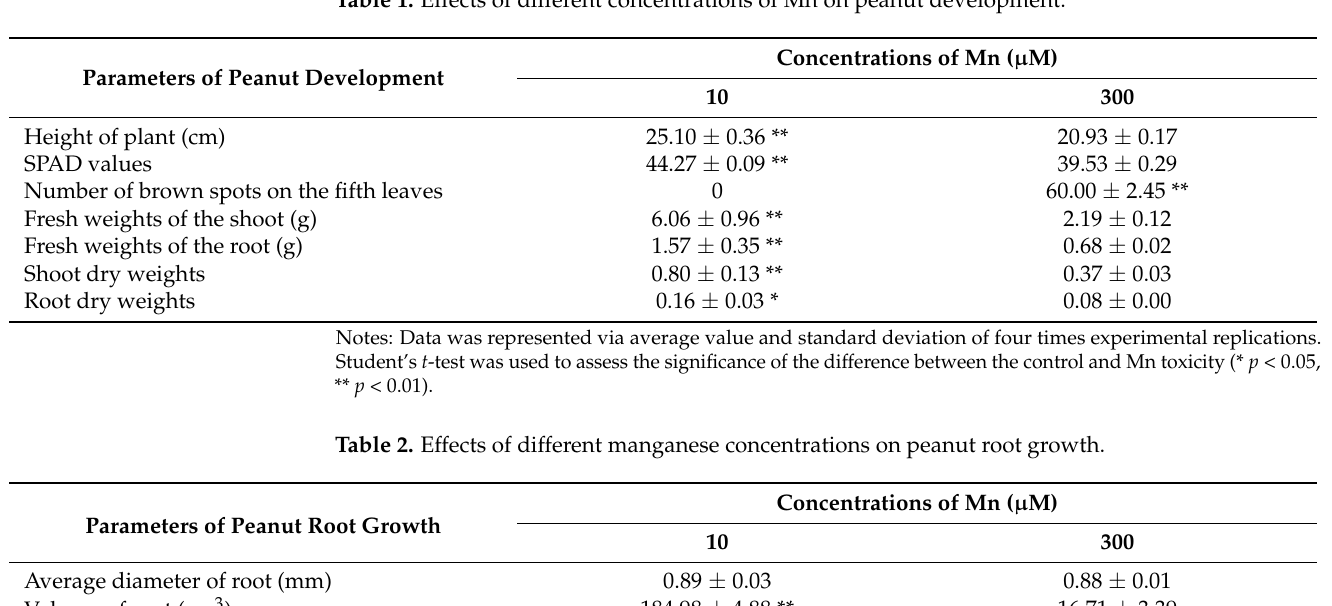
Table 1. Effects of different concentrations of Mn on peanut development.